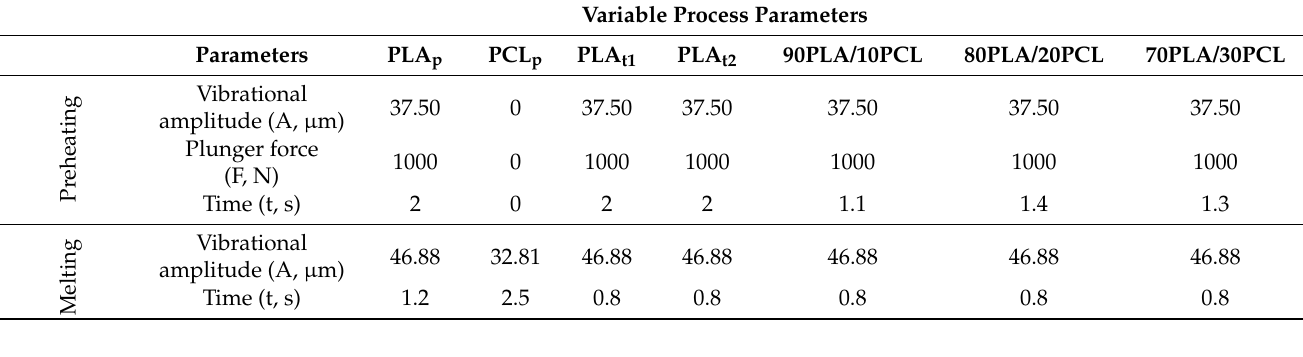
Table 3. Process parameters windows: preheating and melting. Variable Process Parameters